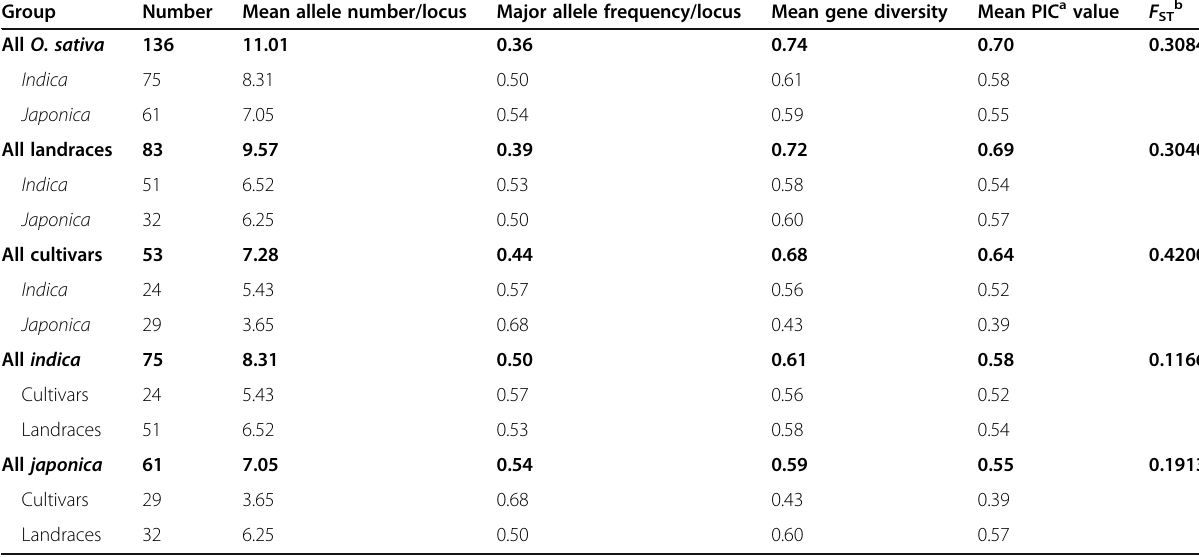
Table 3 Genetic diversity and divergence in O. sativa Group Number Mean allele number/locus Major allele frequency/locus Mean gene diversity Mean PIC a value